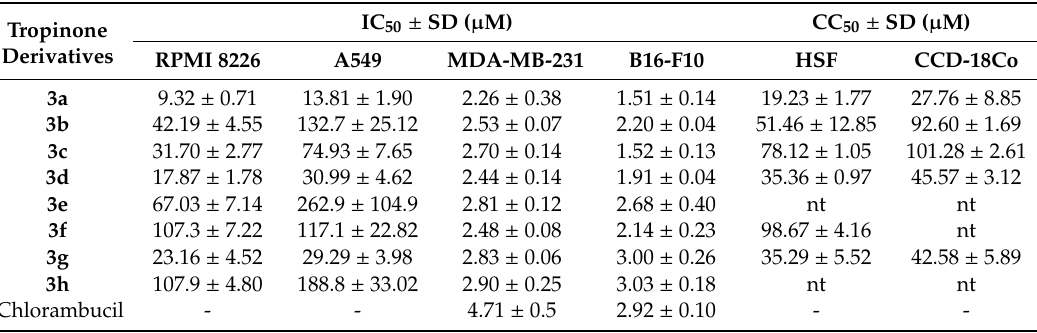
Table 2. Antiproliferative activity of compounds 3a – 3h against human multiple myeloma (RPMI 8226), human lung carcinoma (A549), human breast adenocarcinoma (MDA-MB-231), and mouse